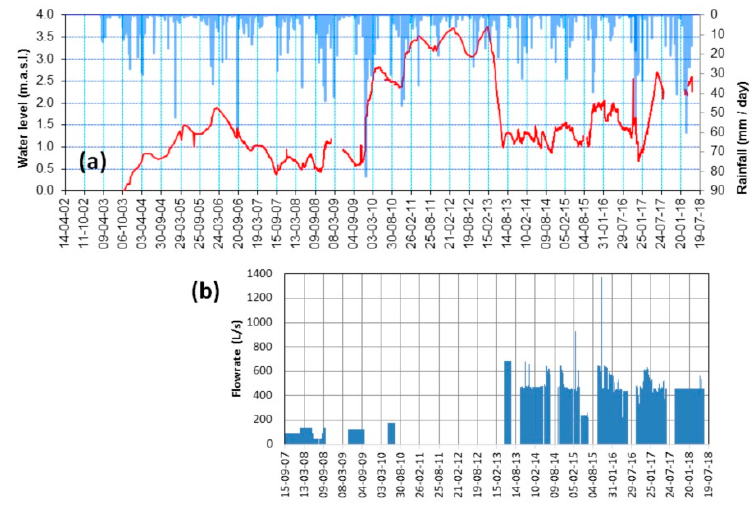
Figure 6. ( a ) Evolution of surface water elevation (wetland Balsa del Sapo) and rainfall (La Mojonera) in the period 2003–2016; ( b ) average daily pumped flow. Location of the rainfall station in Figure 1a.